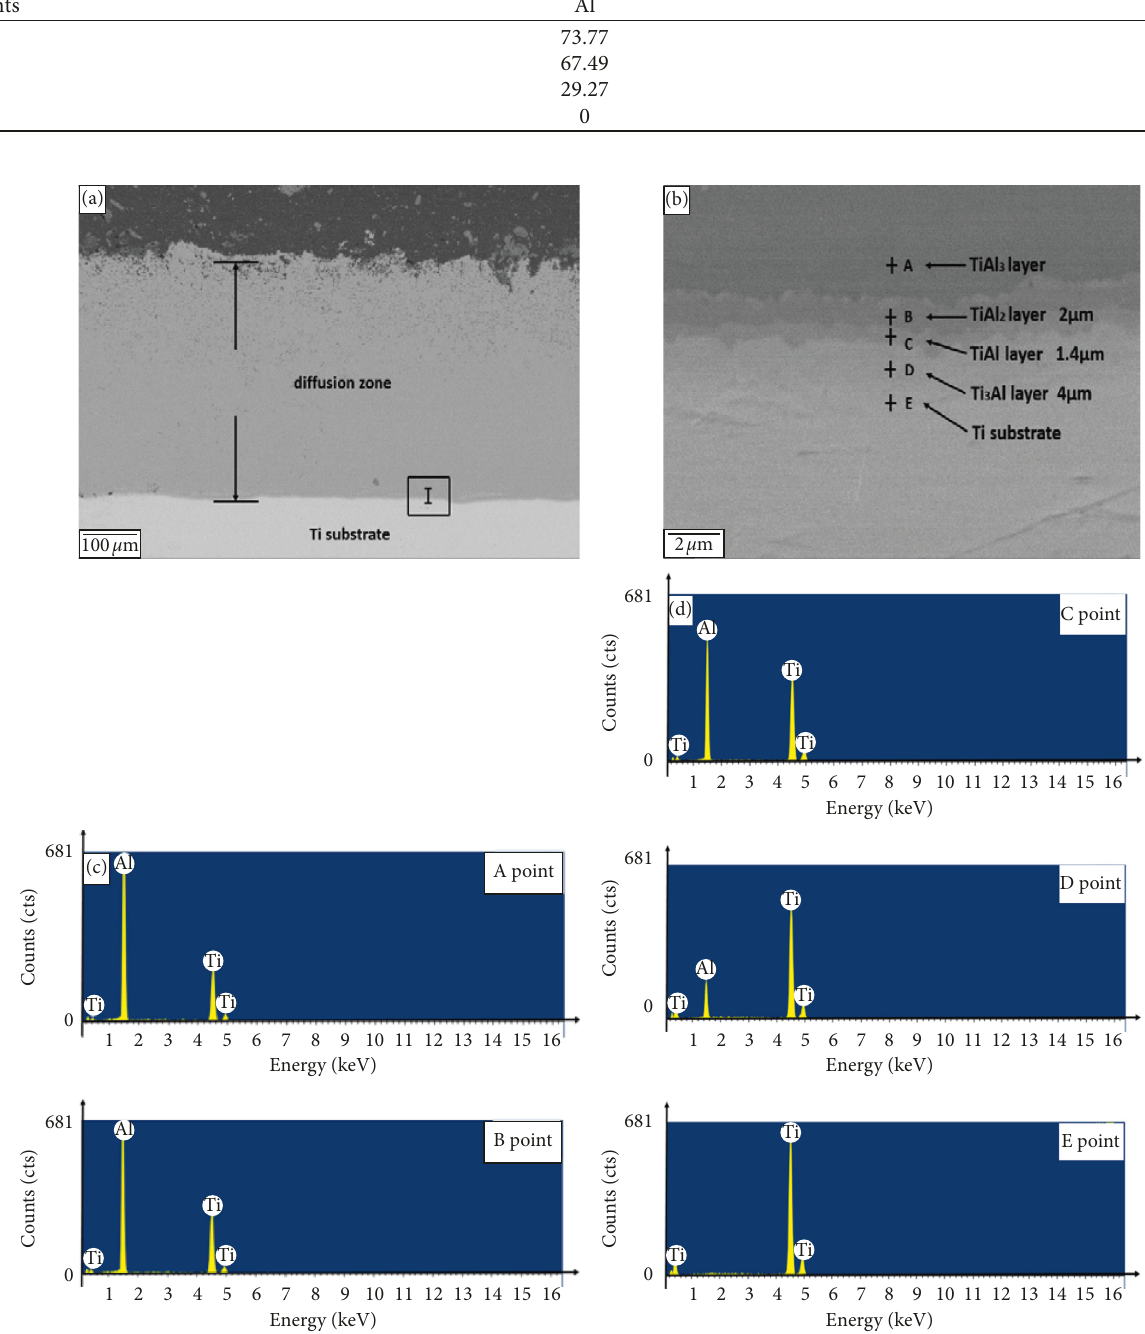
Figure 7: (a) Cross-sectional BSD image of Al coating after testing for 5 hours at 1173 K, (b) the expanded view of region I in Figure 7(a), (c) EDS results of points A and B marked in Figure 7(b), and (d) EDS results of points C, D, and E marked in Figure